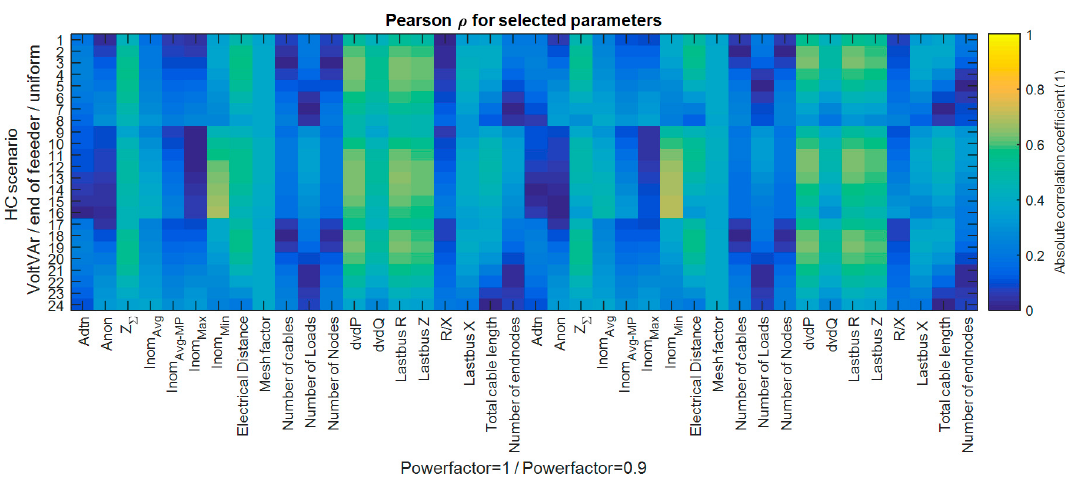
Figure 19. Pearson correlation (HC @ PF = 1 columns 1–8, HC @ PF = 0.9 columns 9–16, HC @ VoltVar columns